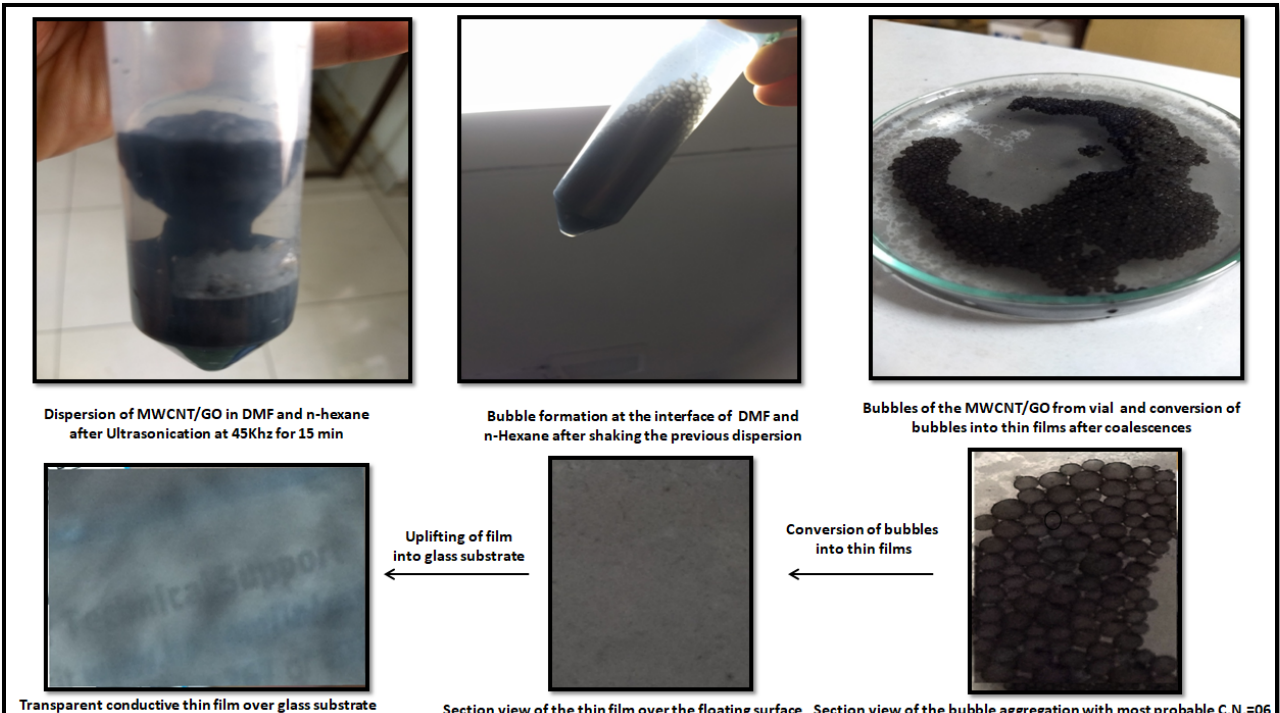
Figure 11. The process diagram for the dispersion and thin film formation of the MWCNT/GO na- nohybrid.